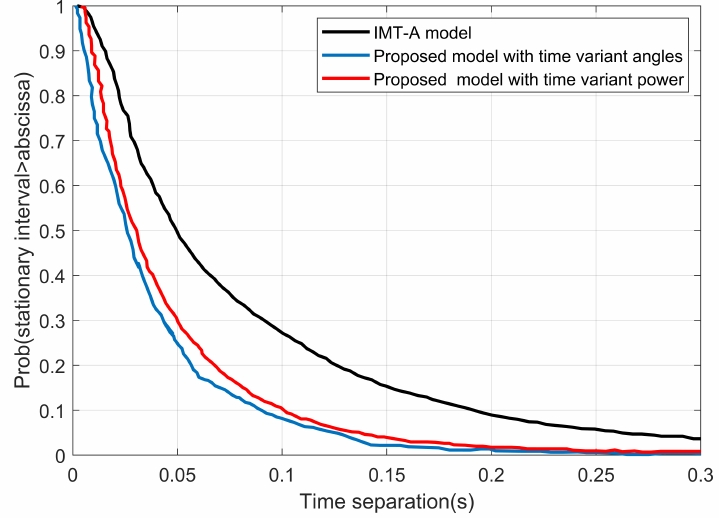
Figure 7. The stationary intervals using the proposed model for time-varying angle, cluster power, and the IMT-A channel.